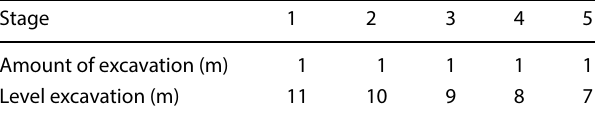
Table 2 Excavation